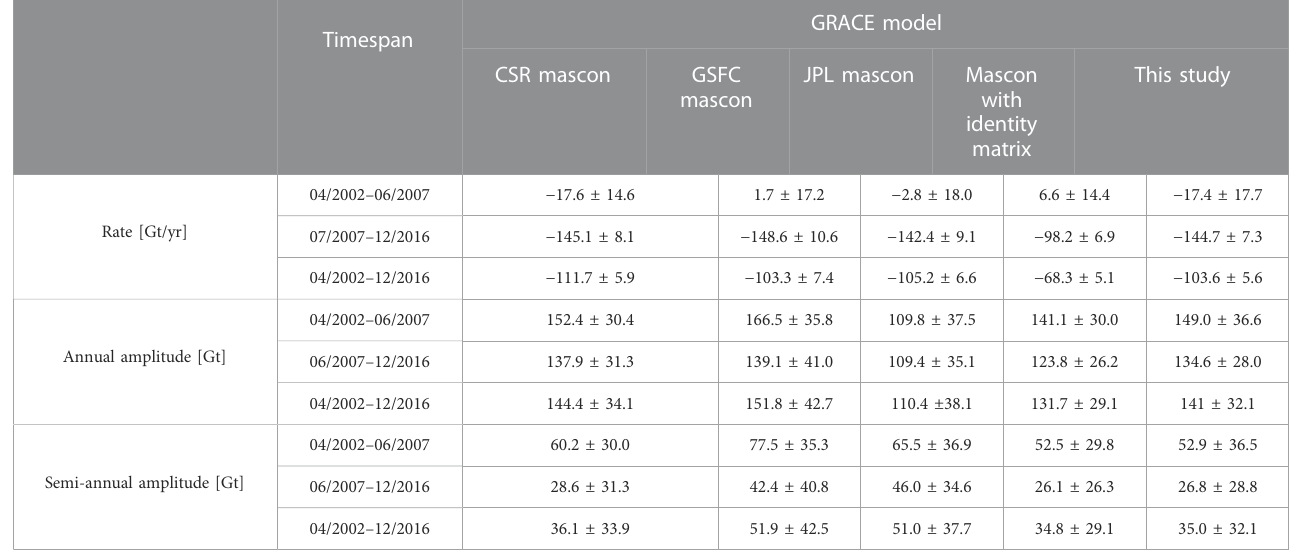
TABLE 5 Rate, annual amplitude and semi-amplitude of mass change signals over